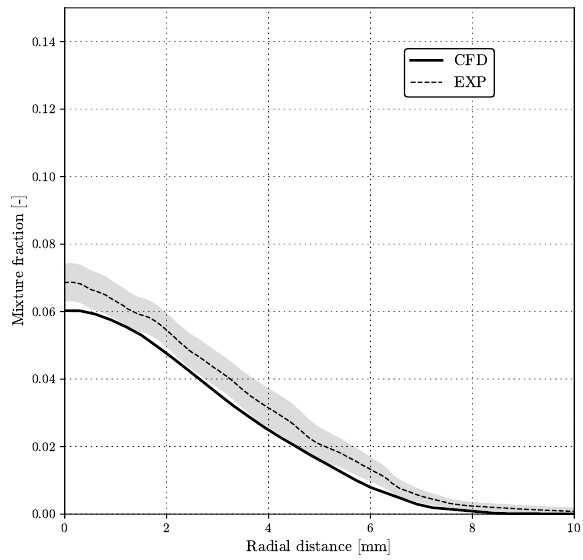
Figure 10. Radial mixture fraction distribution at z = 45